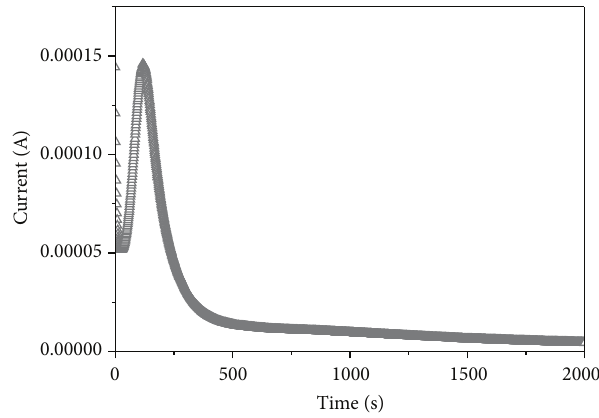
Figure 4: Development of current over time in 0.1M KOH upon illumination of a CdS sample coated with 200 ALD